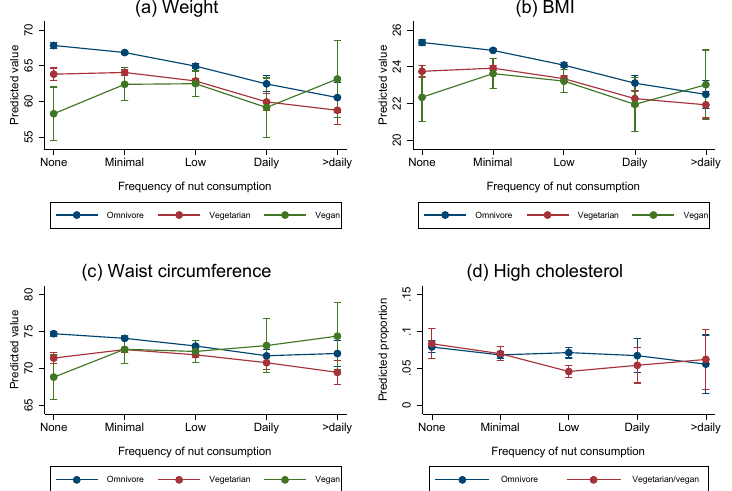
Figure 1. Association between frequency of nut consumption and predicted anthropometric and risk factors by dietary pattern. ( a ) Association between frequency of nut consumption and body weight by dietary pattern; ( b ) association between frequency of nut consumption and BMI by dietary pattern; ( c ) association between frequency of nut consumption and waist circumference by dietary pattern; ( d ) association between frequency of nut consumption and high blood cholesterol by dietary pattern.